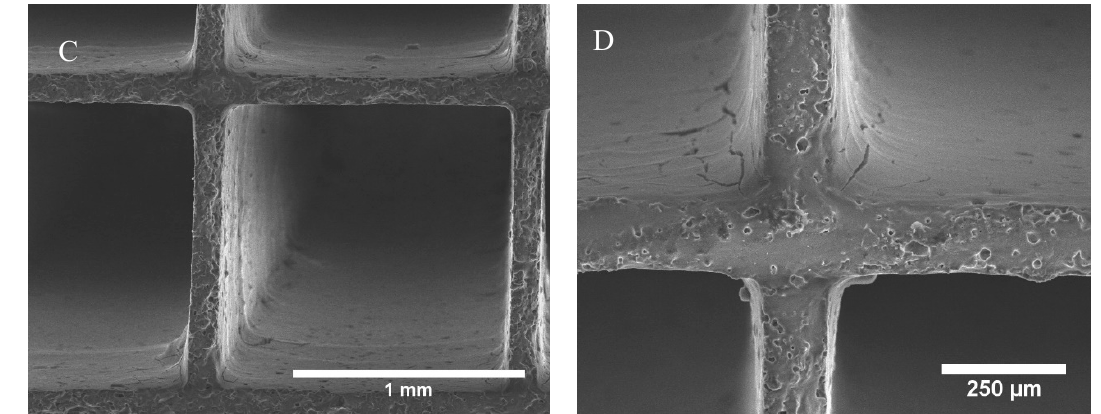
Figure 2. SEM images of the monolith catalysts Pd0Ce ( A , B ) and Pd2Ce , ( C , D ). Table 2. EDX elemental analysis of the monolith catalysts.